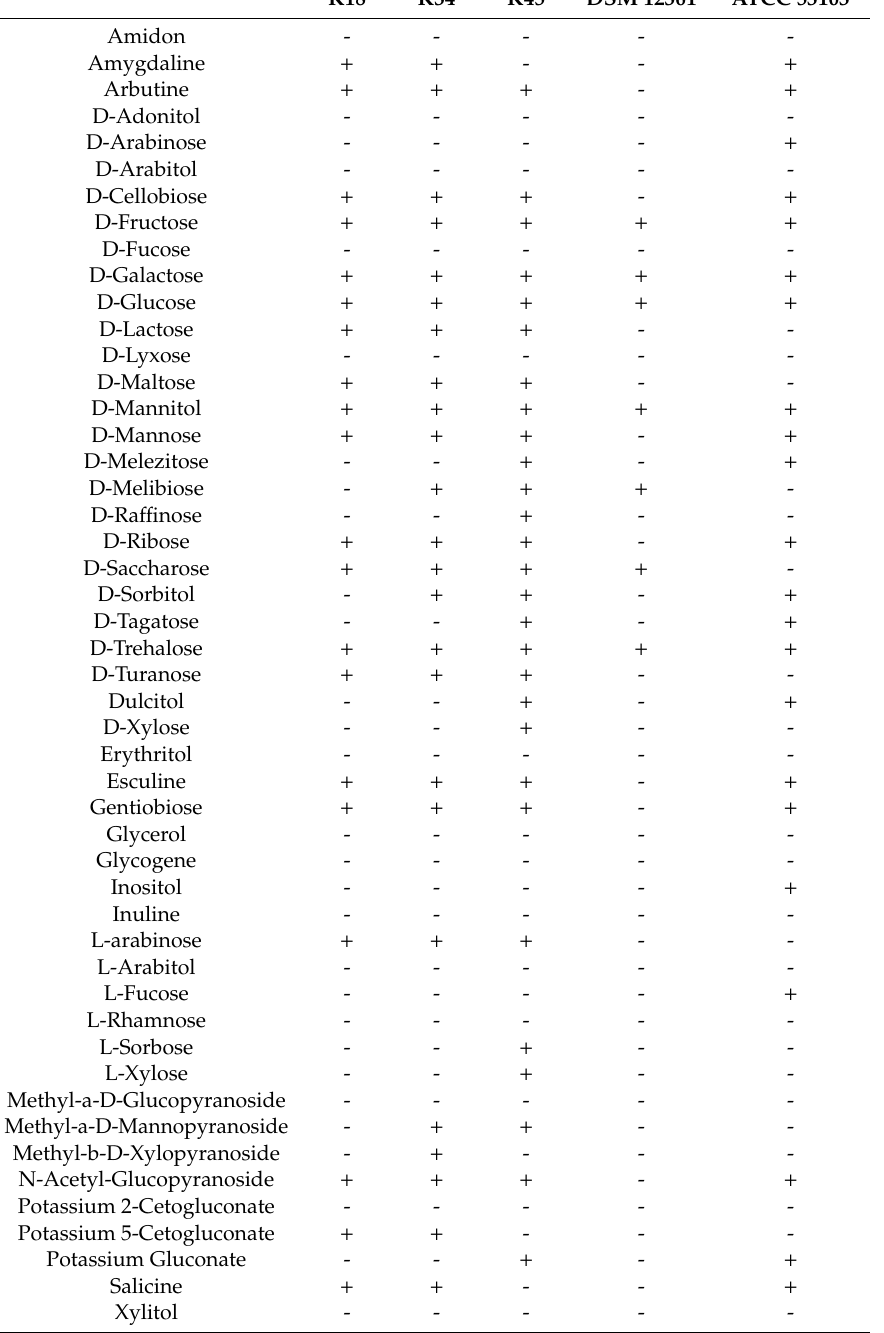
Table 2. Carbohydrates fermented by A. kunkeei K18, K34, K45 and DSM 12361 and L. rhamnosus GG ATCC 53103 detected through API 50 CH